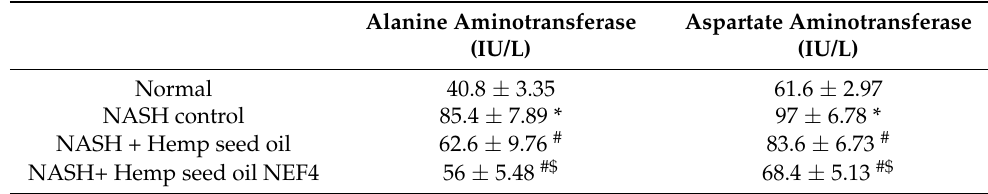
Table 6. Liver enzyme activities in rats with NASH treated with hemp seed oil and